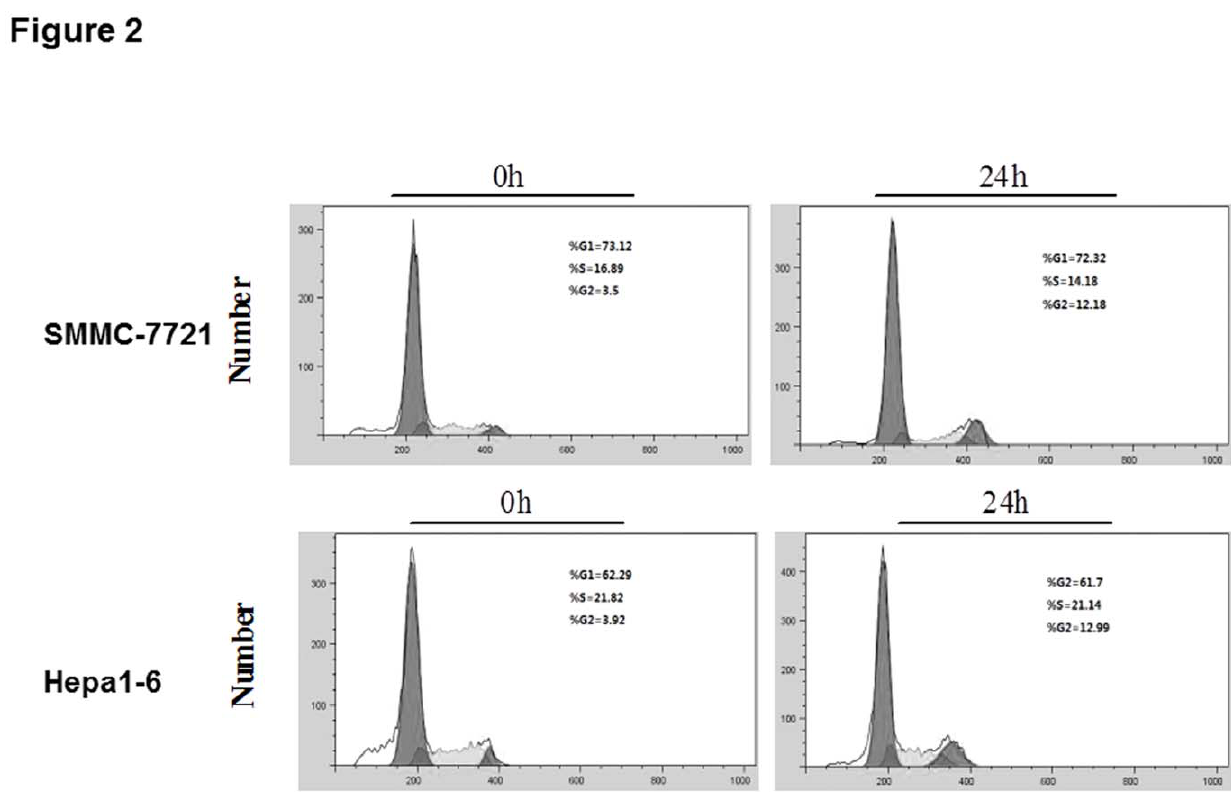
Figure 2. Effects of Osthole on Cell Cycle of HCC Cells. Cell cycle analysis of SMMC-7721 and Hepa1-6 cells following 123.0 m M osthole treatment for 24 h by flow cytometry.